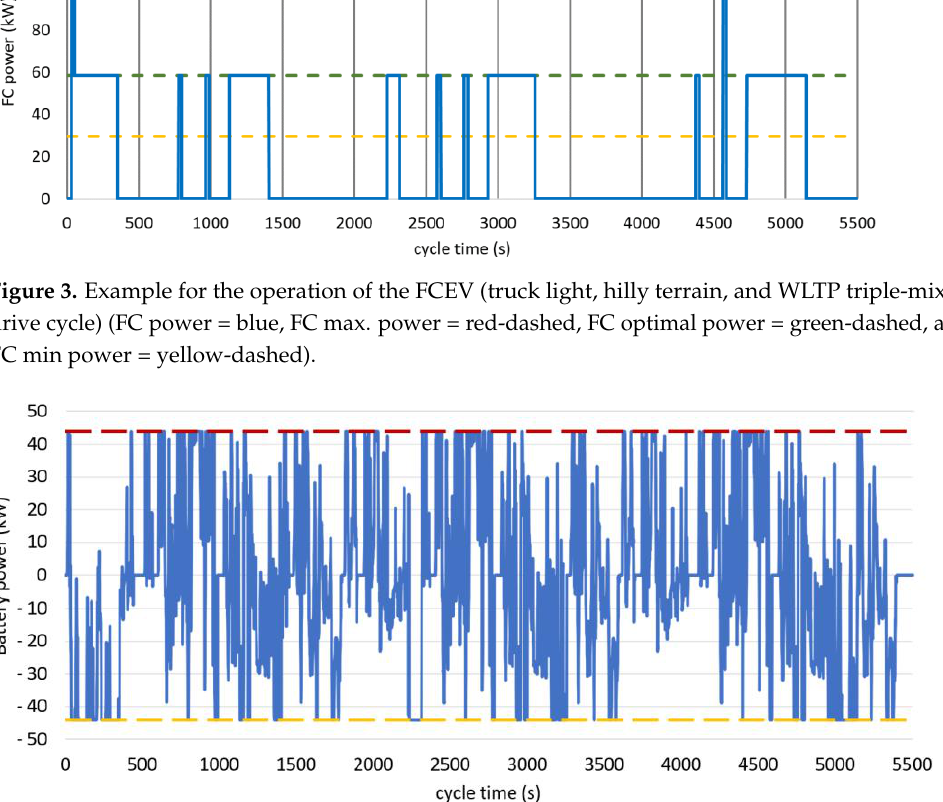
Figure 4. Example for the battery power (blue line) of an FCEV during operation (truck light, hilly terrain, and WLTP triple-mixed drive cycle); (positive values mean discharging, negative mean charging, rated discharge power = red-dashed, and rated charge power = yellow-dashed).